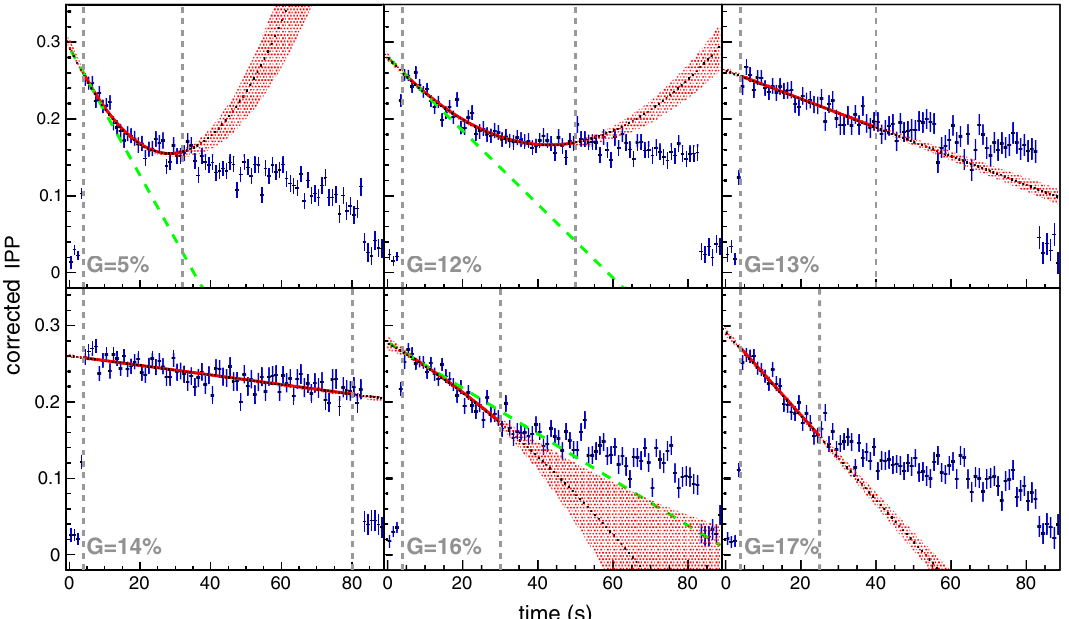
FIG. 10. Panels for representative sextupole values involved in Scan 3 of Fig. 7 for a wide beam and negative polarization. Zero time begins 80s into thestorewhen the data acquisitionwasstarted. Thevalue of I G in terms ofa percentageoffull sextupole currentareincluded ineachpanel. A region(indicated here betweenvertical dashedlines) near the beginningofeachdata setwasreproducedbyeithera linearor a quadratic polynomial (heavy red line). The red region shows the extension of this polynomial, including statistical errors from the fitting process. The green line represents the tangent to this polynomial at 5 s where it differs from a nonlinear polynomial fit.